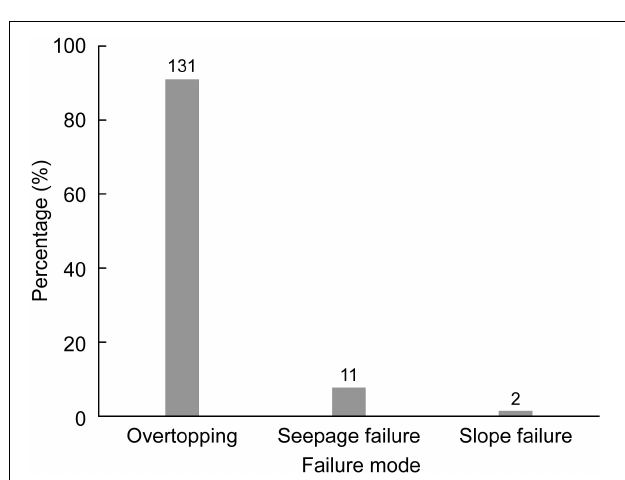
FIGURE 3 | Proportion of landslide dams failed by overtopping, seepage, or downstream slope